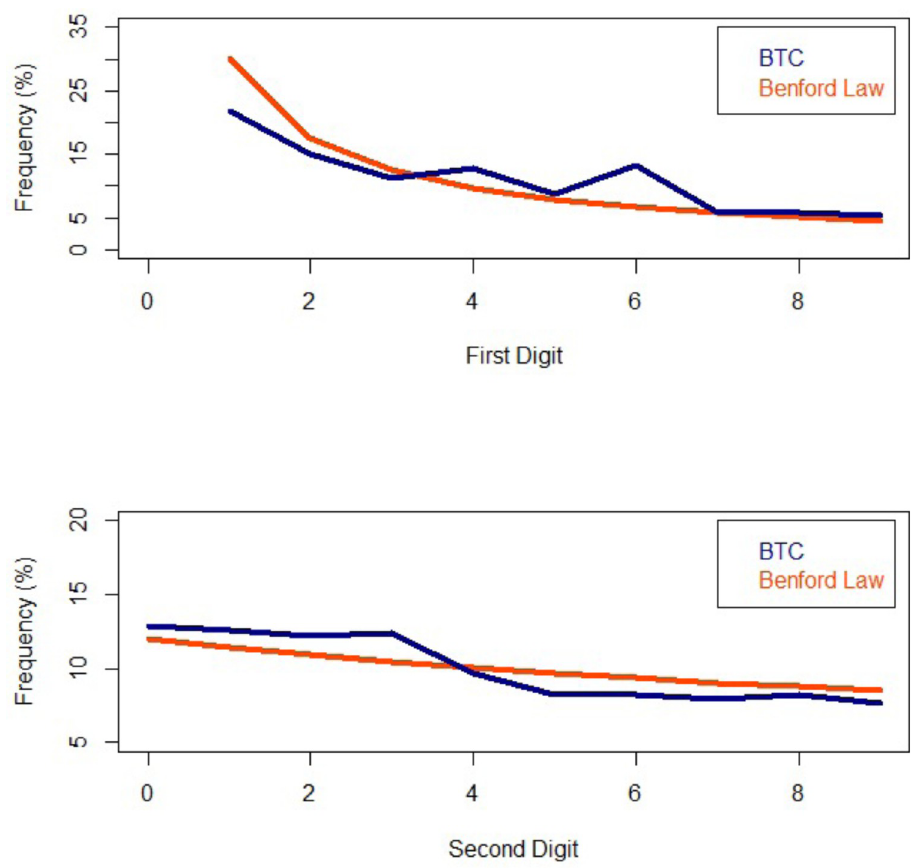
Fig 3. Comparison between Benford law distribution (orange) and BTC prices (blue) since 17.08.2010.